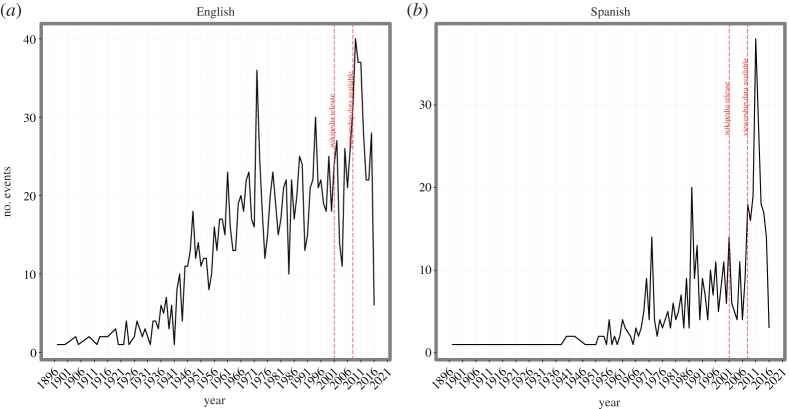
The number of aircraft incidents and accidents per year reported in (a) English and (b) Spanish Wikipedia.